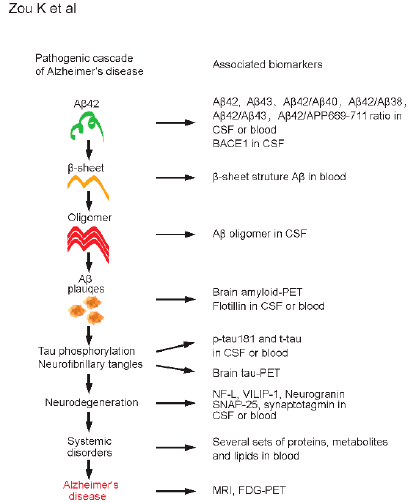
Figure 1. Pathogenic cascade and associated biomarkers of Alzheimer’s disease (AD). Amyloid cascade hypothesis of AD is shown on the left side. Selected and associated biomarkers at each pathogenic stage of AD are shown on the right side. A β 42, amyloid β -protein 42; A β 43, amyloid β -protein 43; A β 40, amyloid β -protein 40; A β 38, amyloid β -protein 38; APP, amyloid precursor protein; BACE1, β -site APP-cleaving enzyme 1; CSF, cerebrospinal fluid; PET, positron emission tomography; p-tau, phosphorylated tau; t-tau, total tau; NF-L, neurofilament light; VILIP-1, visinin-like protein 1; SNAP-25, synaptosome-associated protein 25; MRI, magnetic resonance imaging; FDG,